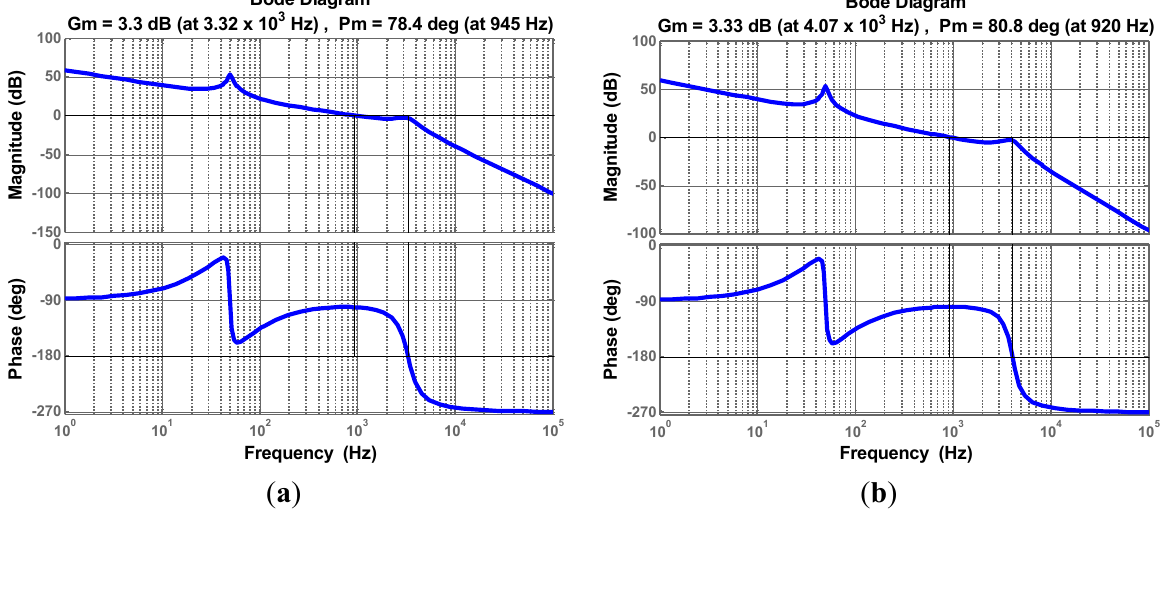
Figure 13. System Bode diagram under different parameters: ( a ) capacitor C increased by 20%; ( b ) capacitor C decreased by